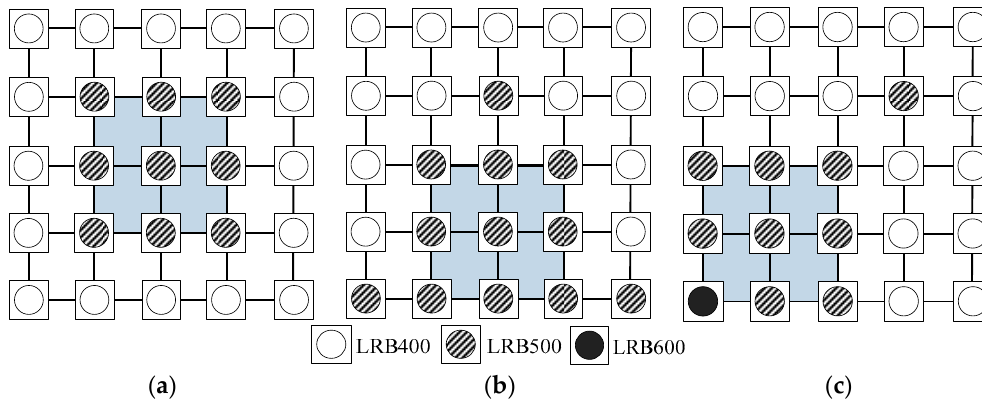
Figure 3. Isolation bearing layout. ( a ) Model A; ( b ) Model B; ( c ) Model C.